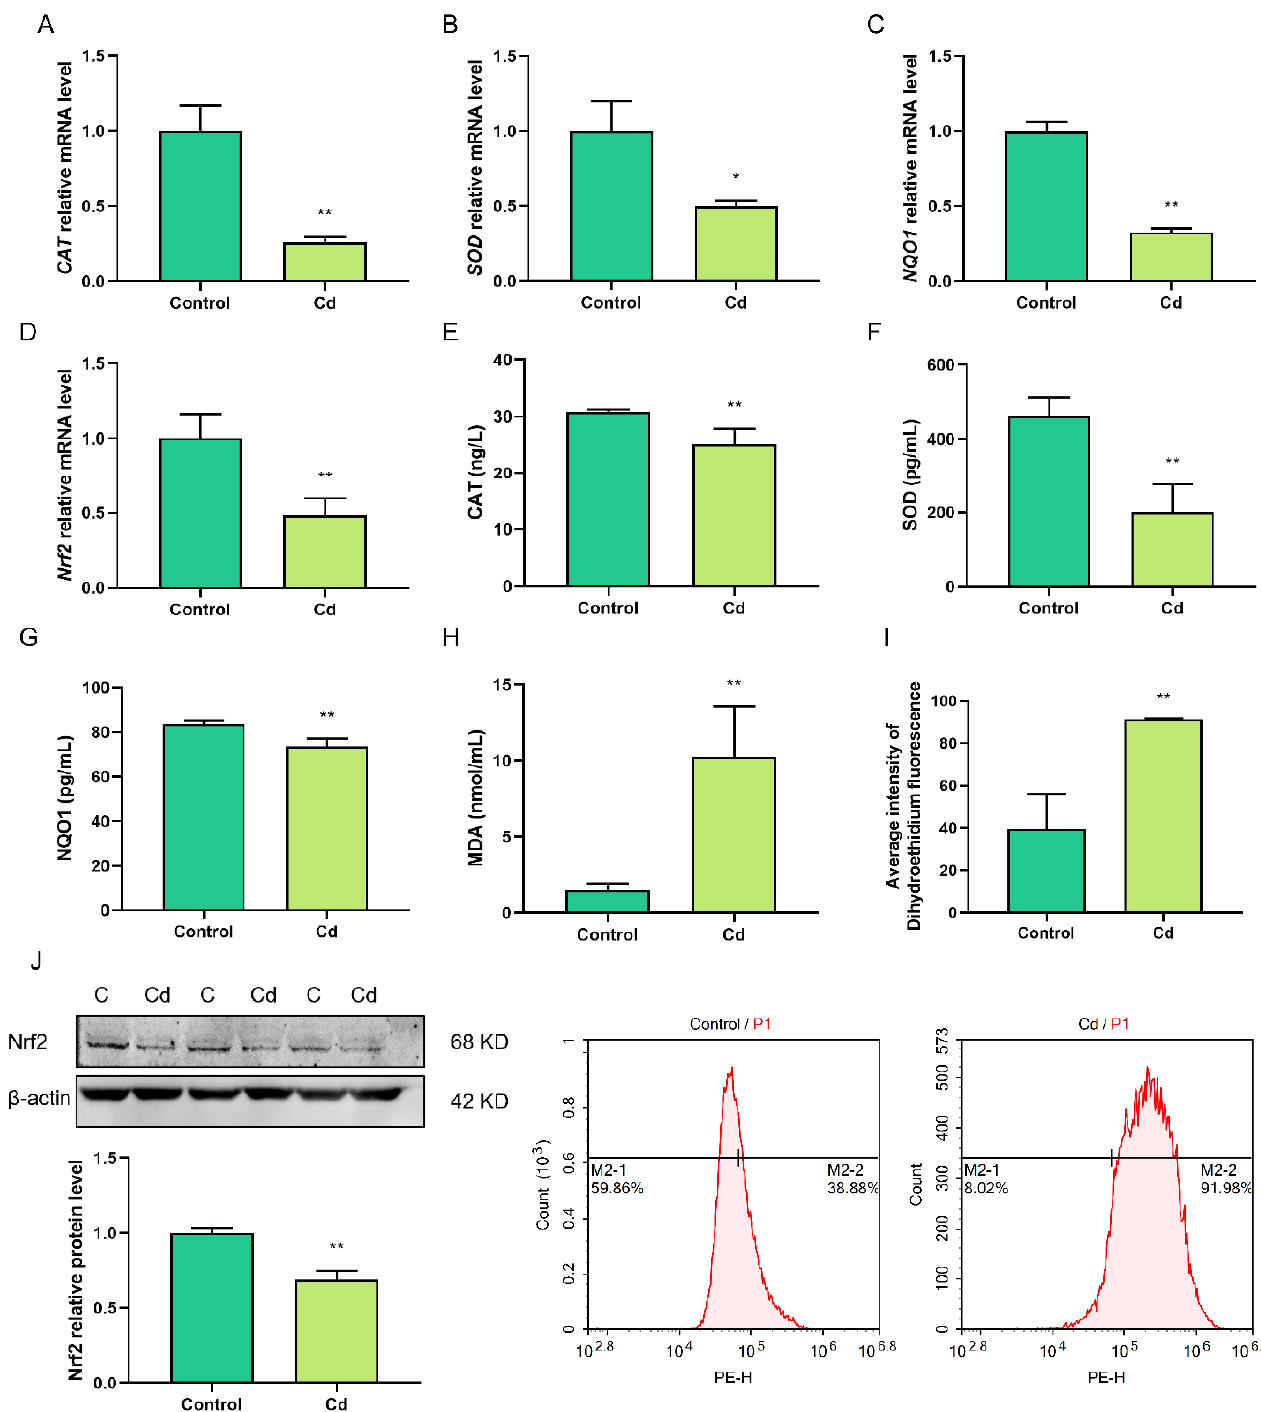
Figure 2. Cd ‐ induced oxidative stress in granulosa cells. ( A – C ) RT ‐ qPCR results revealed the transcript levels of CAT , SOD , and NQO1 after Cd treatment. ( D ) RT ‐ qPCR results revealed the transcript levels of Nrf2 after Cd treatment. ( E – H ) ELISA results revealed the intracellular levels of CAT, SOD, NQO1, and MDA after Cd treatment. ( I ) Intracellular reactive oxygen species (ROS) was measured using flow cytometry analysis (DHE) in the control and Cd groups. ( J ) Nrf2 protein levels were analyzed by Western blotting after Cd treatment. * p < 0.05; ** p < 0.01.